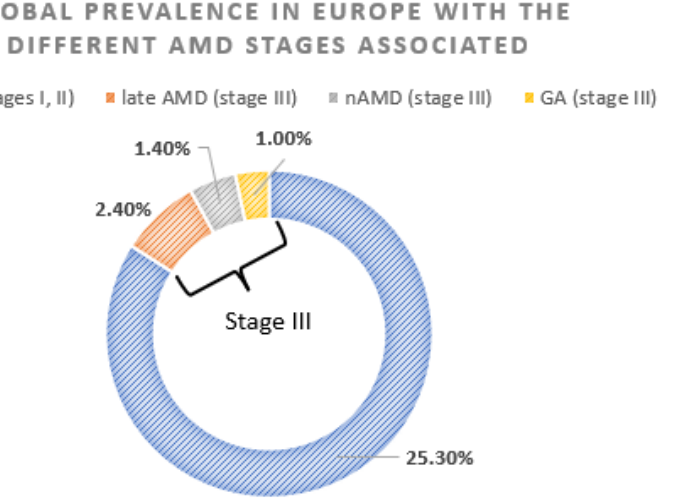
Figure 5. Prevalence in Europe for all ages (from <64 years to >75 years). eAMD: early AMD. nAMD: neovascular AMD. GA: geographic atrophy.